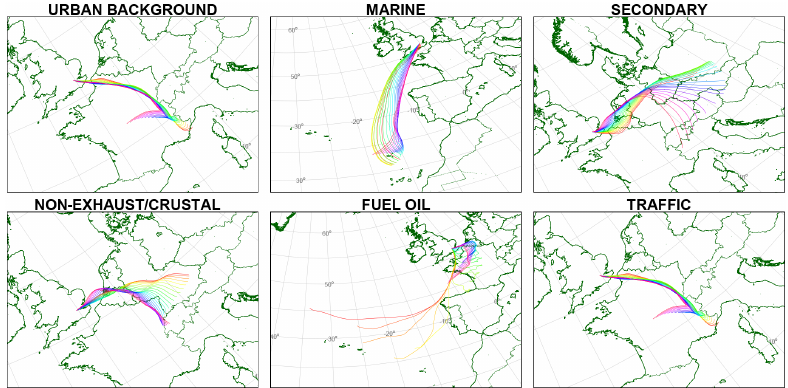
Figure 7. Back trajectories corresponding to the vertical red lines in Fig. 6, which indicate when each factor has the highest contribution to PM 10 : 20 November 2011 – urban background; 23 December 2012 – marine; 18 February 2011 – secondary; 21 April 2011 – non-exhaust and crustal; 15 August 2012 – fuel oil; 20 November 2011 – traffic.